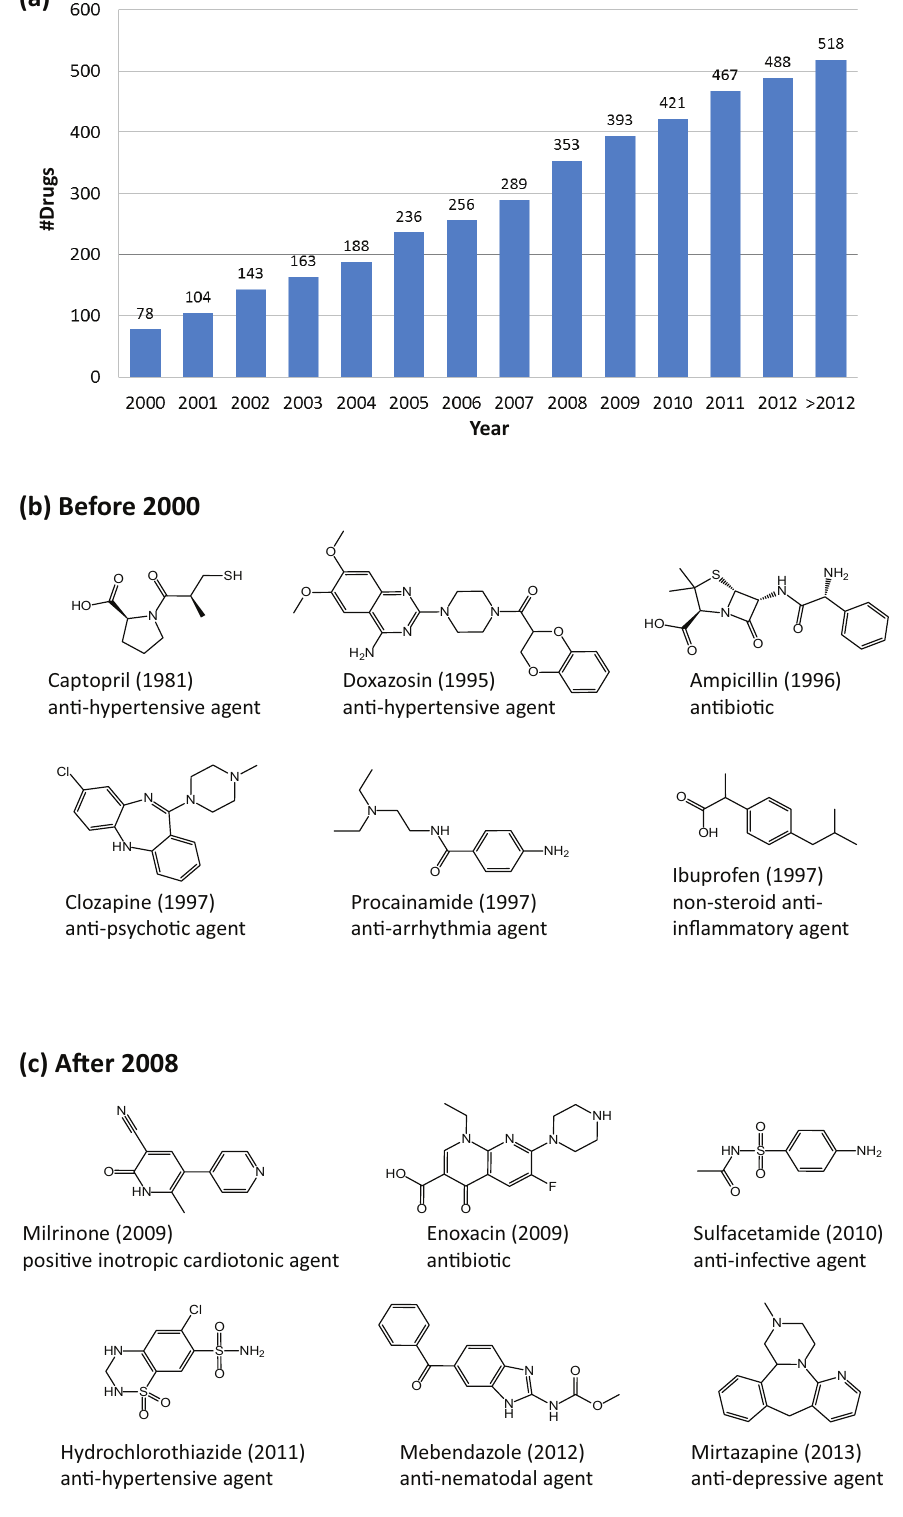
Figure 5. Monitoring high-confidence drug activity data over time. ( a ) Reported is the cumulative number of drugs for which high- confidence activity data became available in different years. In ( b ) and ( c ), six exemplary approved drugs are shown for which high-confidence activity data were first recorded before 2000 or after 2008, respectively. For each drug, its name, year of first data report, and therapeutic indication are